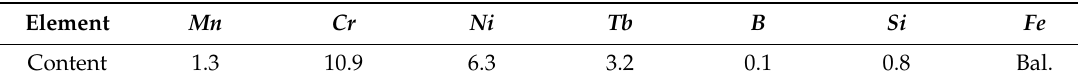
Table 3. Chemical composition of Fe -based alloy powder (wt / %).